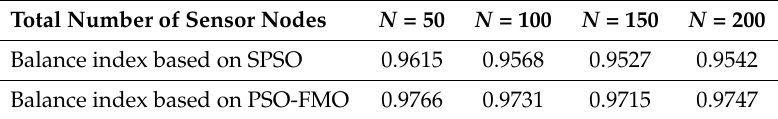
Table 2. Balance Index of the Number of Sensor Nodes between